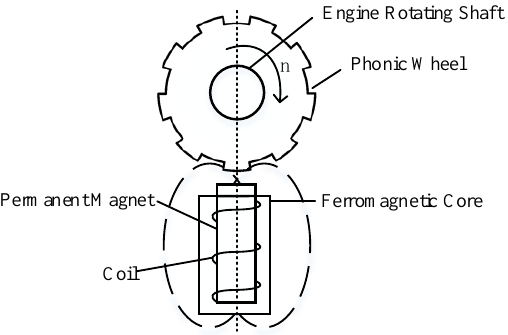
Figure 3. Magnetoelectric speed sensor diagram.